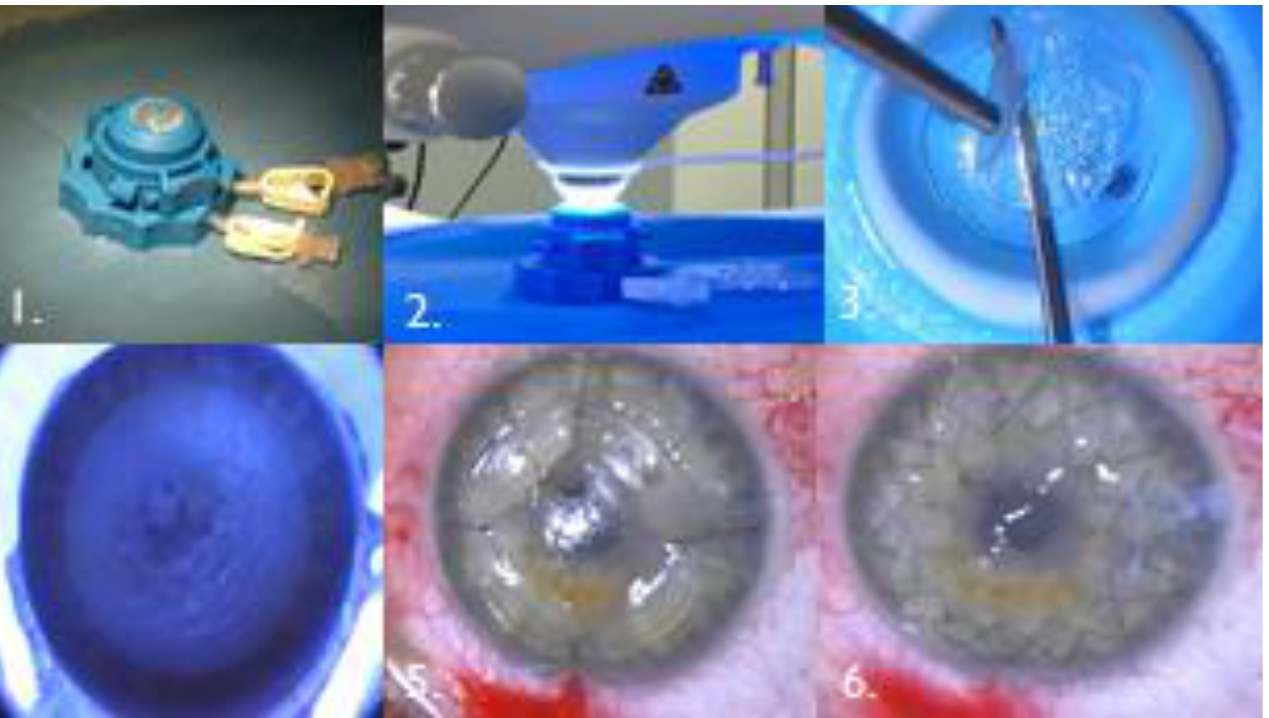
Figure 1. 1 . The procedure commenced with the placement of the donor tissue into an artificial anterior chamber, 2 . that was then moved under the laser’s head. 3 . After the laser had created a corneal lenticule, the flaps were separated from the rest of the corneoscleral donor tissue using a blunt spatula., if necessary, corneal scissors. 4 . The reci-pient corneal bed was then prepared in the same way. 5 . First sutures were laid in cardinal positions. 6 . The eye after continuous suture. Topical antibiotic drops (Vigamox, Alcon, Forth Worth, TX, USA) were administered, Tears Naturale (Alcon), and topical 0.1% Dexamethasone (Polfarma, Warszawa, Poland) slowly tapered over 3 – 4 months. Sutures were removed during the follow-up controls in patients with high astigmatism exceeding 4.0 diopters starting from 6 months post-op, and hybrid contact lenses were tried (Figure 2). All patients had the sutures removed at 12 months post-op.